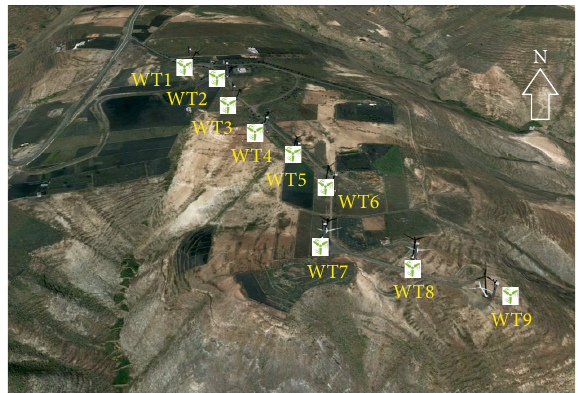
Figure 1: Distribution of the four wind turbines of WF-1 on Gran Canaria island [29].